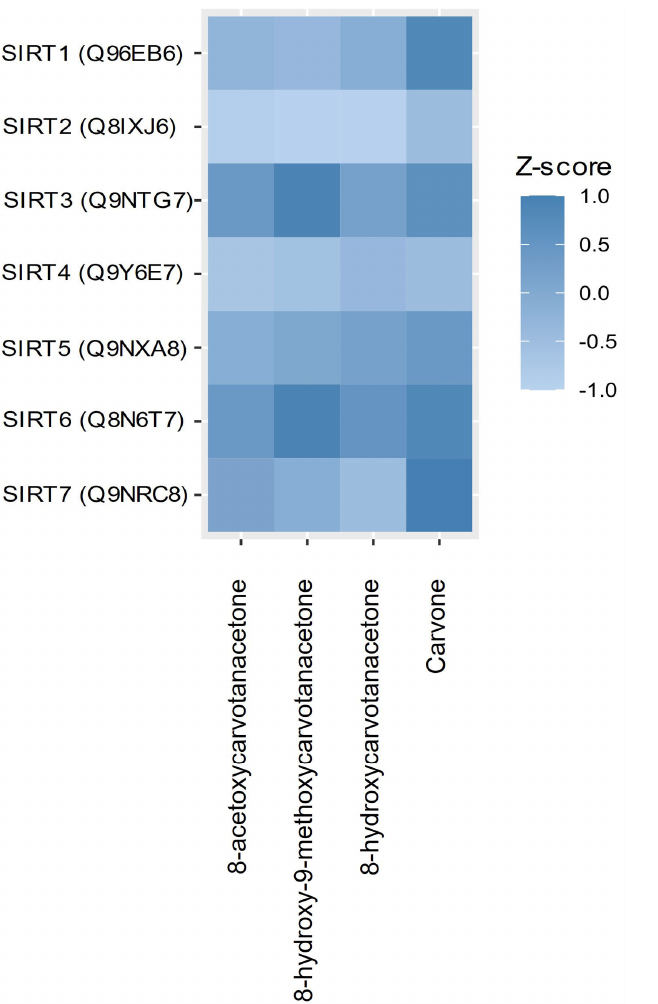
Figure 9. Heatmap of the z-score calculated using the DTI prediction model for the interaction of carvone derivatives with human SIRTs.